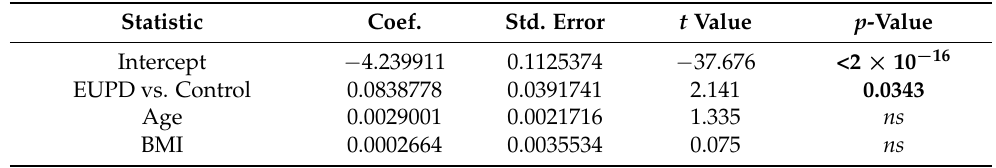
Table 2. Robust Linear Regression Contrasting Mean BDNF Methylation Levels to Disease Status (EUPD or Control). Statistic Coef.